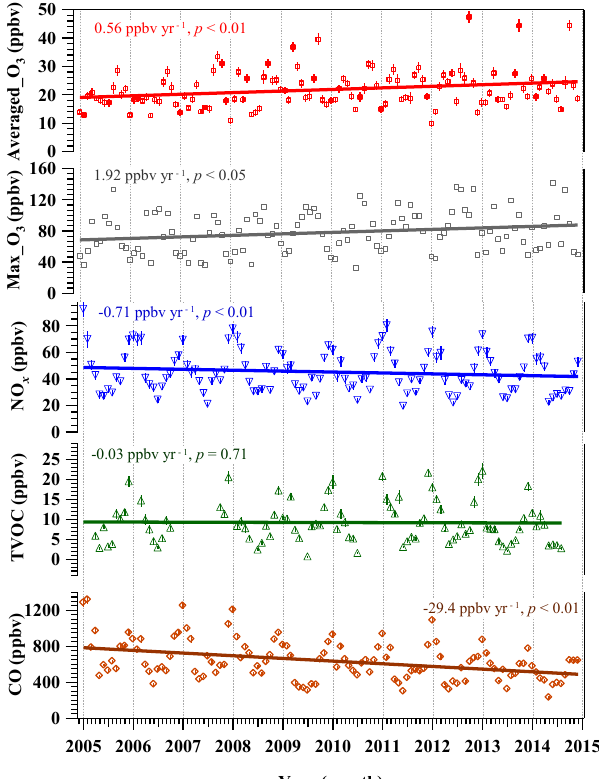
Figure 2. Trends of monthly averages of O 3 and its precursors, i.e. NO x , TVOC, and CO at TC during 2005–2014. Error bars represent 95% confidence intervals of monthly